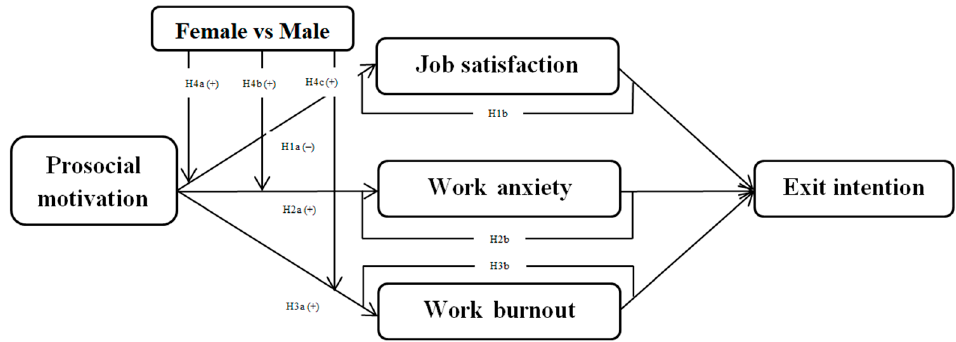
Figure 1. Theoretical